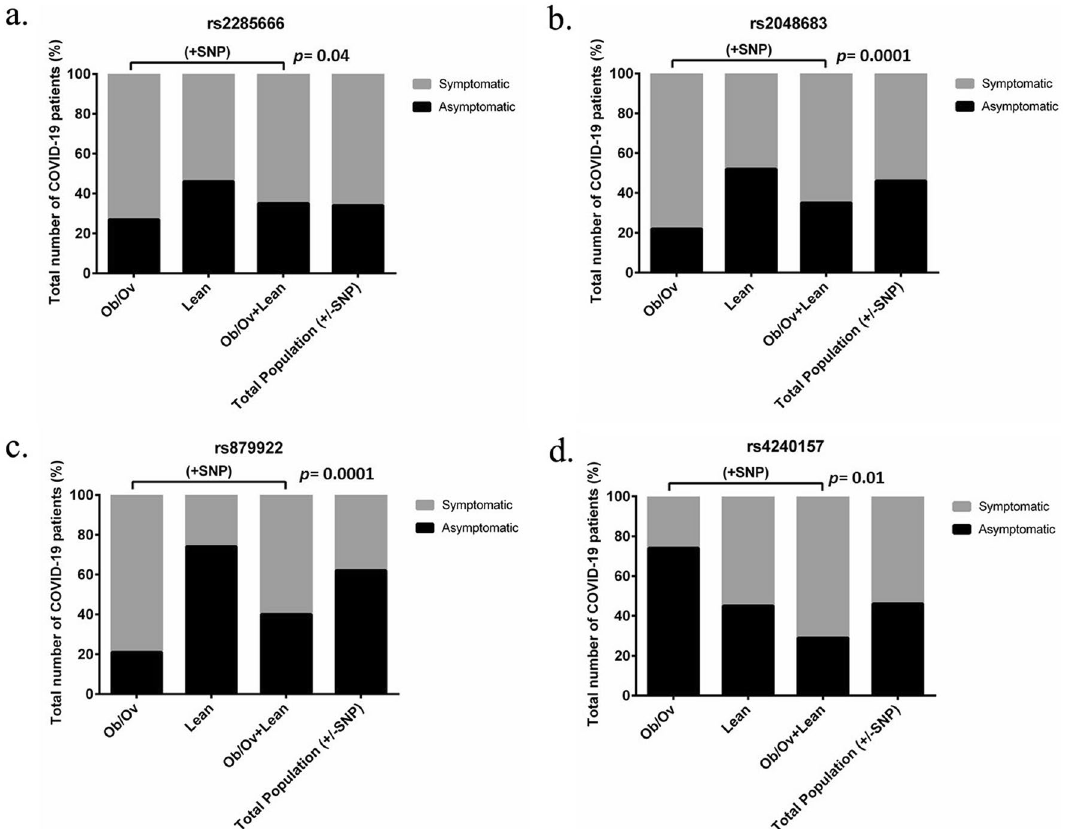
Figure 3. COVID-19 obese subjects expressing ACE2 variants are more symptomatic than COVID-19 lean subjects. ( a ) rs2285666, ( b ) rs2048683, and ( c ) rs879922 are significantly correlated to the incidence of symptoms in COVID-19 obese/overweight subjects. The variant ( d ) rs4240157 is significantly correlated to the incidence of symptoms in COVID-19 lean subjects. A contingency test using Chi-square analysis was applied for each variant. Variation Existing